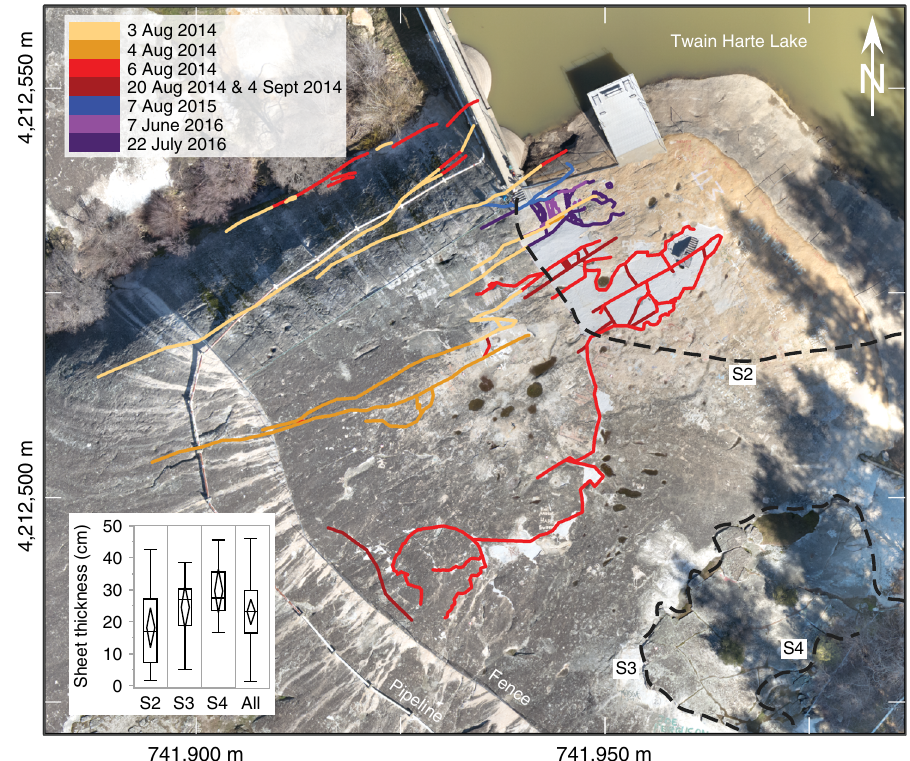
Fig. 2 Fracture mapping of recent and older exfoliation at Twain Harte Dome. Fractures (both surface-parallel and perpendicular) formed during events of 2014 – 2016 — colored by date — indicate exfoliation progressed fi rst to the south and then to the northeast. Mean thickness (inset), measured along transects (dashed lines — S3, S4), of past exfoliation sheets is slightly larger than the mean thickness of newly exposed sheets on the dome surface (S2), re fl ecting that thinner sheets formed during recent exfoliation and have eroded from older generations. Note that the top of sheet S1 (not labeled) is formed by the newly exposed exfoliation surface; its thickness across a transect cannot be easily measured. Base image (NAD83, UTM Zone 10 grid shown) created from UAS (drone) orthophotography as part of this study. Inset box-and-whisker plot elements: horizontal line = median; diamond = mean (center) and 95% con fi dence interval; box = 25th to 75th quantiles; whiskers = all data